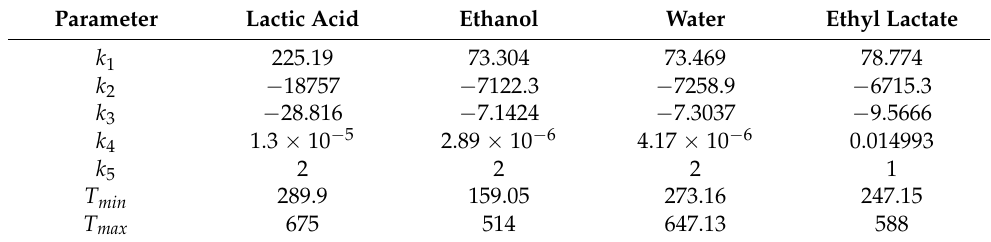
Table A1. Extended Antoine equation parameters.